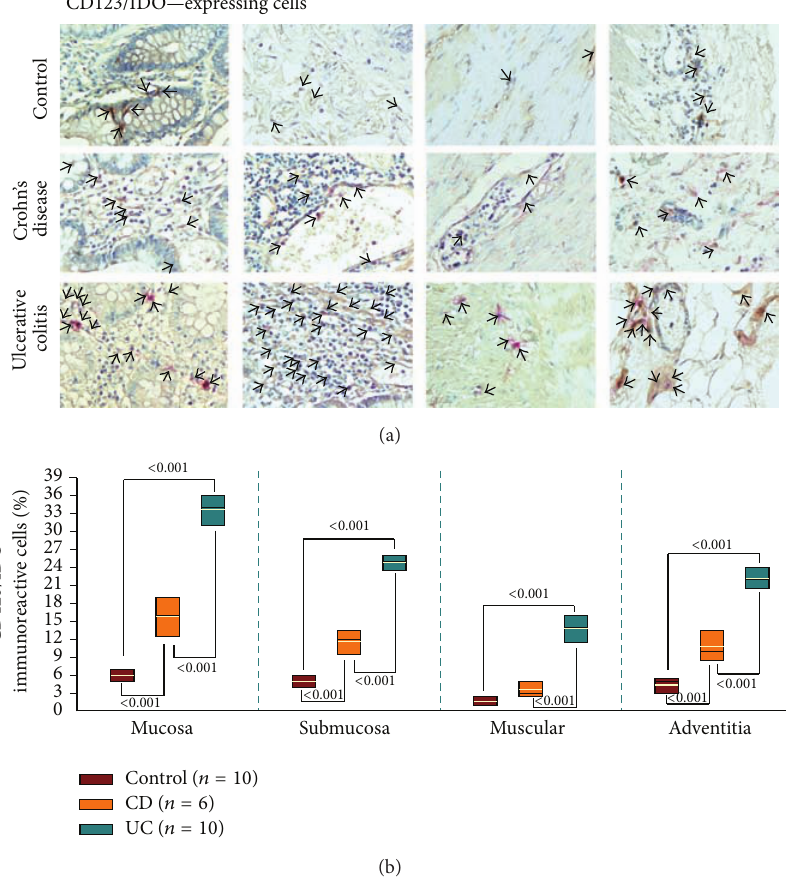
Figure 7: CD123 + /IDO + cells in colonic mucosa from IBD (UC and CD) patients. (a) Representative immunoperoxidase of CD123/IDO expression in non-inflamed colonic tissue (upper panel), in tissue from an active CD patient (middle panel), and in colonic mucosa from an active UC patient (lower panel). From the left to the right photomicrographs represent mucosa, submucosa, muscular, and adventitia. Arrows depict CD123 (in brown)/IDO (in pink) immunoreactive positive cells (X320). (b) Bars indicate immunohistochemistry analysis of IDO-producing cells in non-inflamed colonic tissues, in tissues from active CD patients, and in colonic mucosa from active UC patients. Results are expressed as median (black line), 10th, 25th, 75th, and 90th percentiles. Yellow line represents the